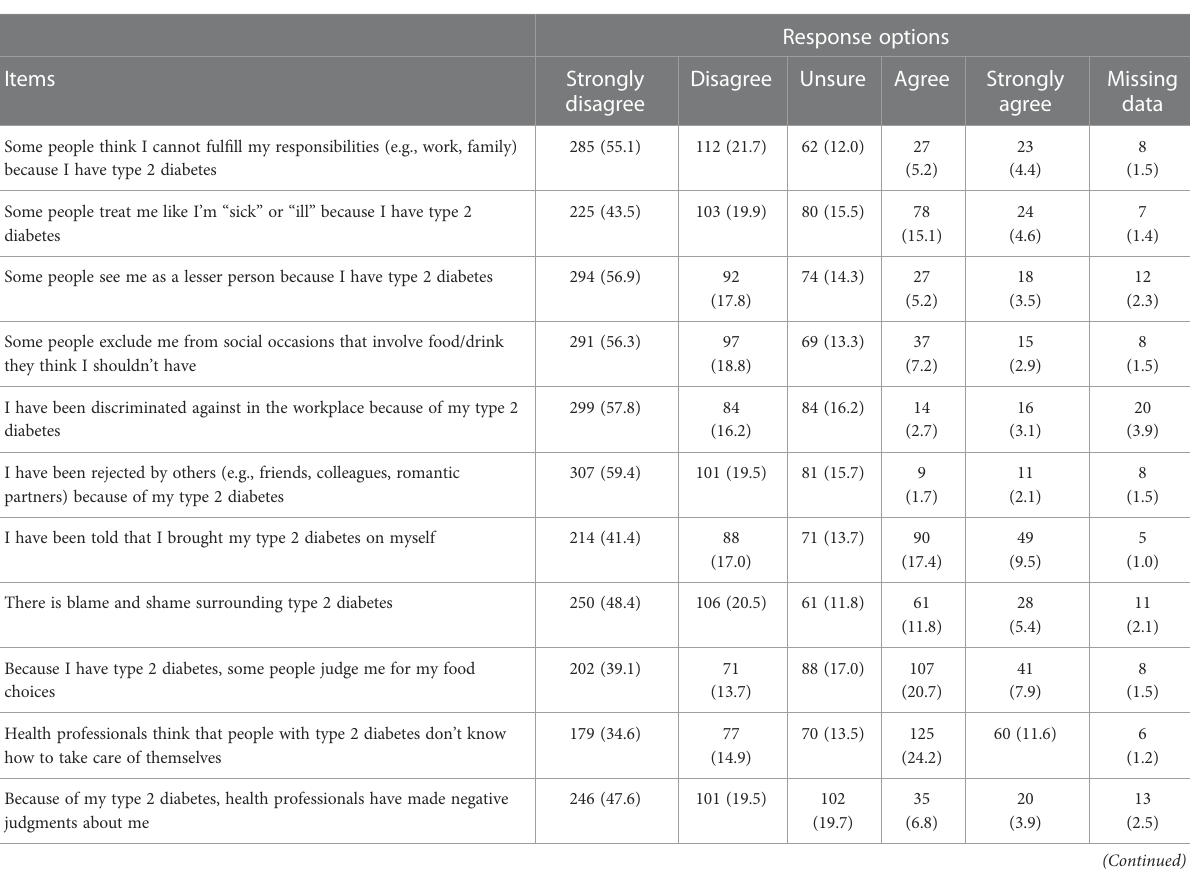
TABLE 3 DSAS-2 Spa-US item response patterns and missing data